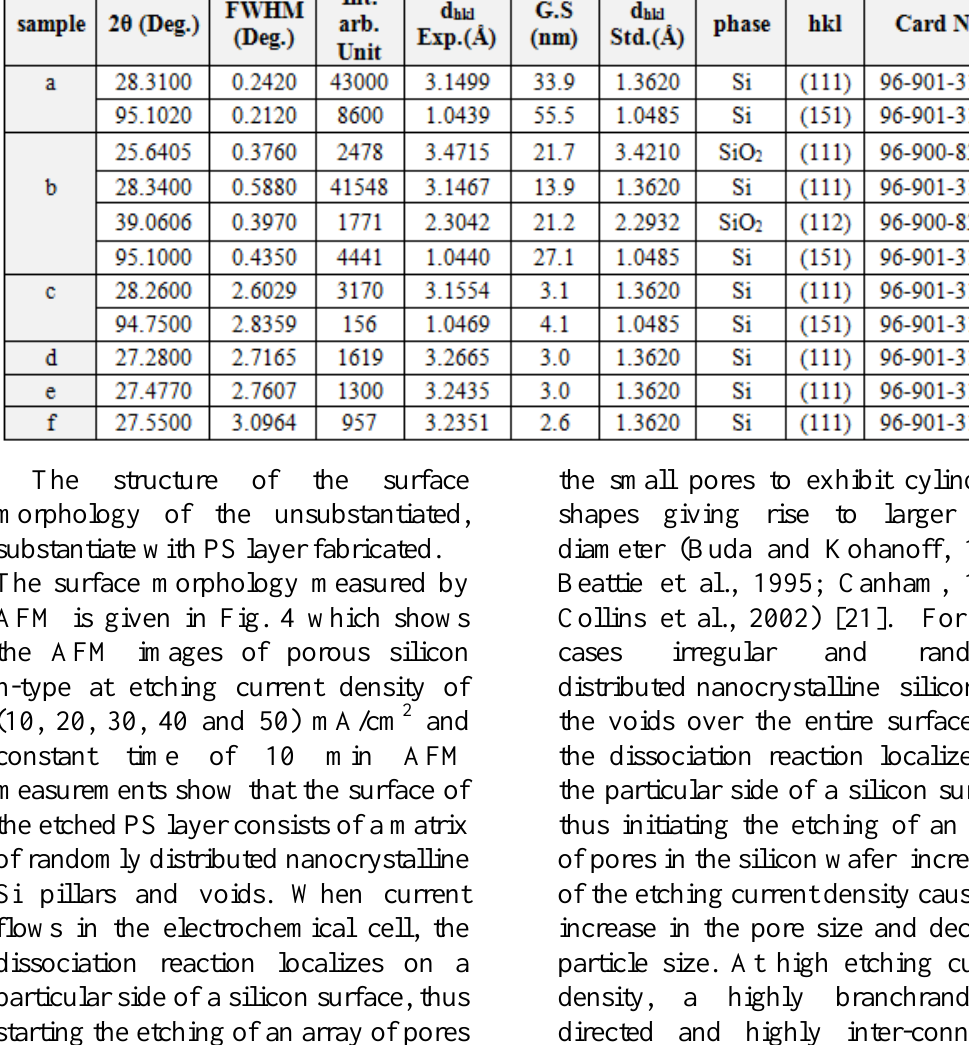
Table 1: Comparison between experimental d